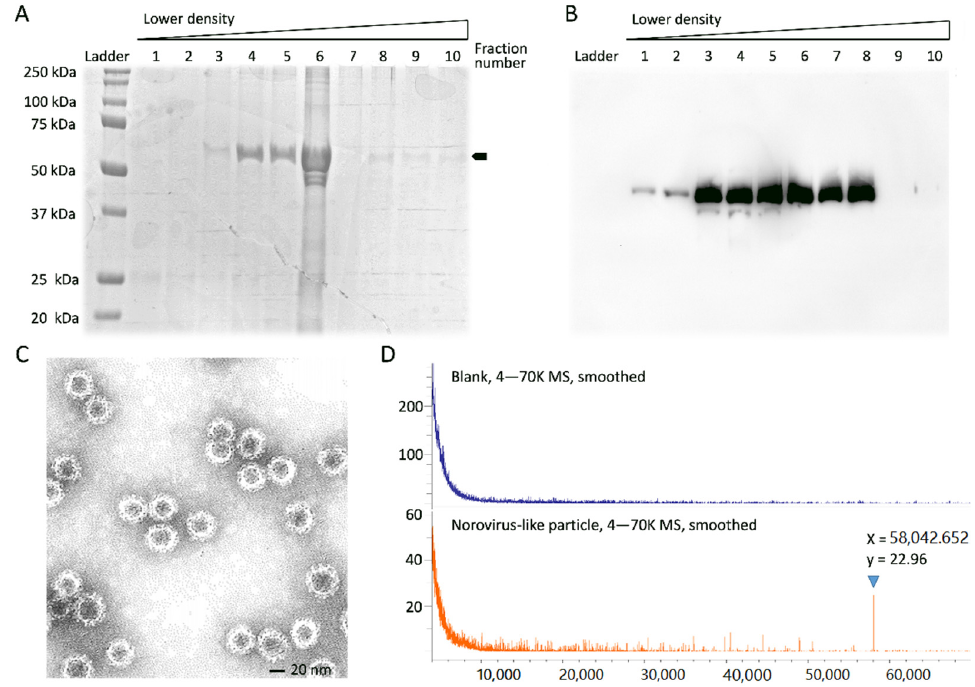
Figure 1. Recombinant norovirus VP1 capsid protein. ( A ) Coomassie blue-stained SDS-PAGE gel for fractions of VP1 proteins; ( B ) Western blot using a polyclonal antibody against VP1 protein; ( C ) Norovirus-like particles under transmission electron microscopy (TEM-HT7700; Hitachi Global); ( D ) MALDI-TOF MS analysis reveals a peak at 58,043 m/z (Autoflex III; Bruker Daltonics, Bruker Corp.).